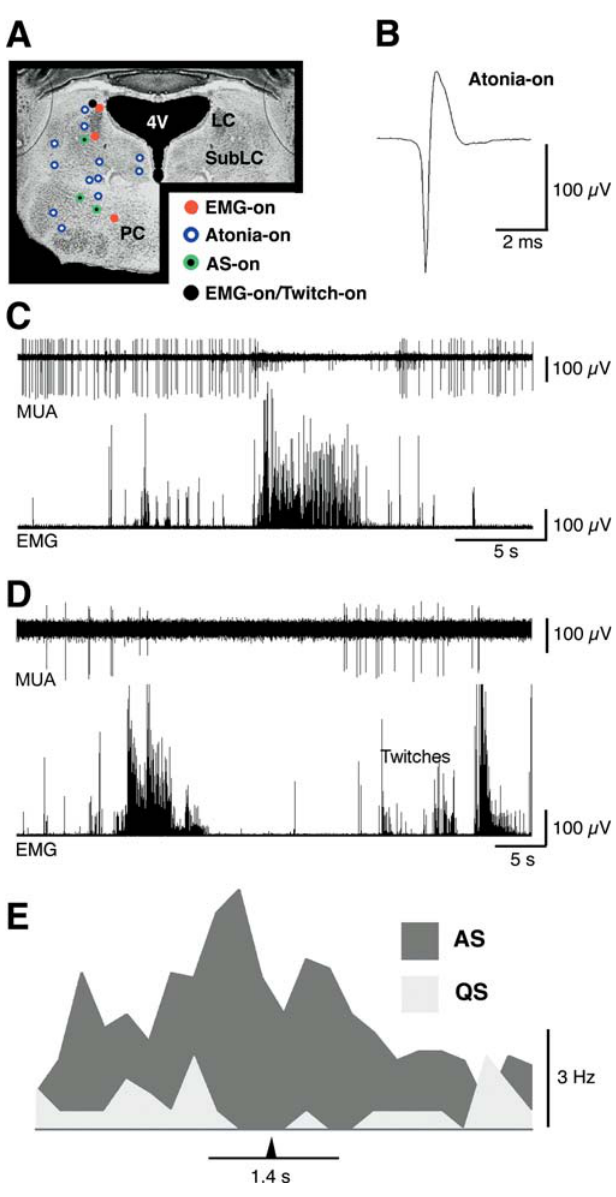
Figure 5. State-Dependent Neural Activity within the Mesopontine Region (A) Recording sites of state-dependent neurons reconstructed on a coronal section at the mesopontine level of a P8 rat. Note the predominance of atonia-on neurons. (B) Averaged waveform of a representative atonia-on neuron. (C) Upper trace: multiunit activity. Lower trace: concurrently recorded nuchal EMG. Spike sorting revealed two units that are easily distinguished by their amplitudes. The higher-amplitude unit is atonia-on; note its tonic discharge throughout the atonia period. (D) Upper trace: multiunit activity. Lower trace: concurrently recorded nuchal EMG. Spike sorting revealed two units that are easily distinguished by their amplitudes. The higher-amplitude unit is AS-on; note the absence of multiunit activity at the onset of the atonia period and then the increase in activity coinciding with the appearance of nuchal twitches. (E) Mean discharge rates of a representative AS-on neuron during bouts of AS and QS as defined, respectively, by the presence or absence of phasic nuchal twitches during periods of atonia. The arrowhead indicates the midpoint of the AS and QS bouts. 4V, fourth ventricle; LC, locus coeruleus; PC, nucleus pontis caudalis; SubLC, subcoeruleus; DOI: